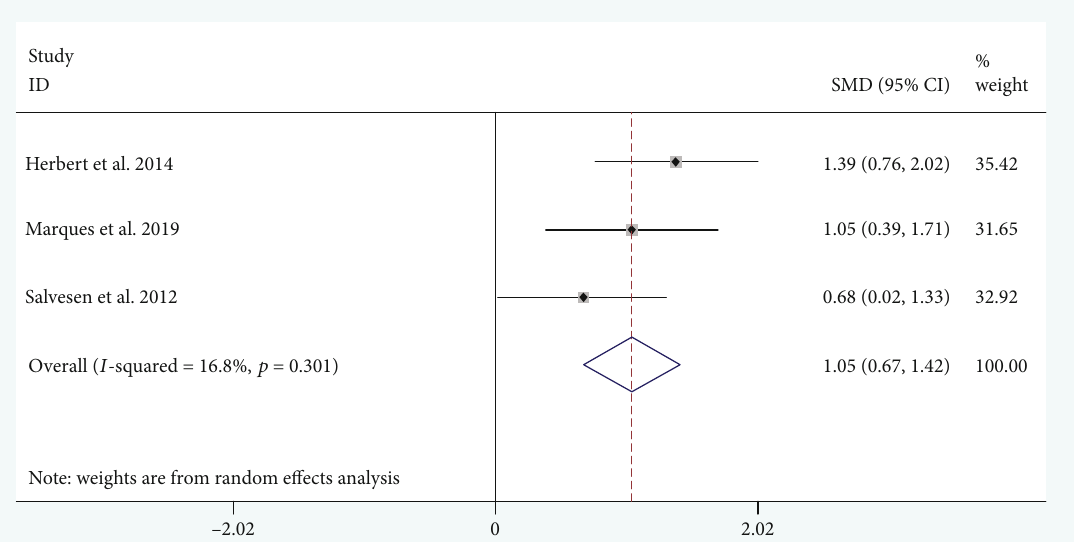
Figure 6: Cerebrospinal fl uid (CSF) levels of DJ-1 in multiple system atrophy (MSA) cohorts were higher than those in Parkinson ’ s disease (PD)